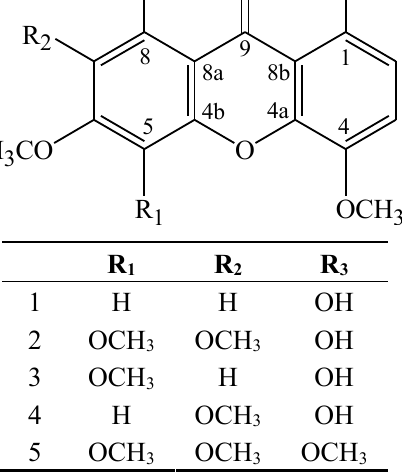
Figure 1. Xanthones from Moutabea guianensis